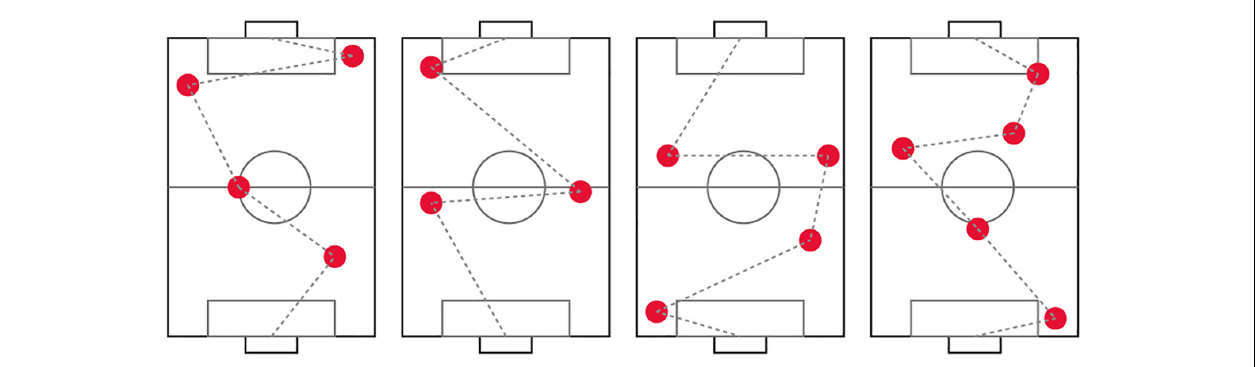
FIGURE 3 | The four predefined maps with the locations of the objects (red circles), including a line indicating the default route of the robot. The bottom of the field is the starting point.